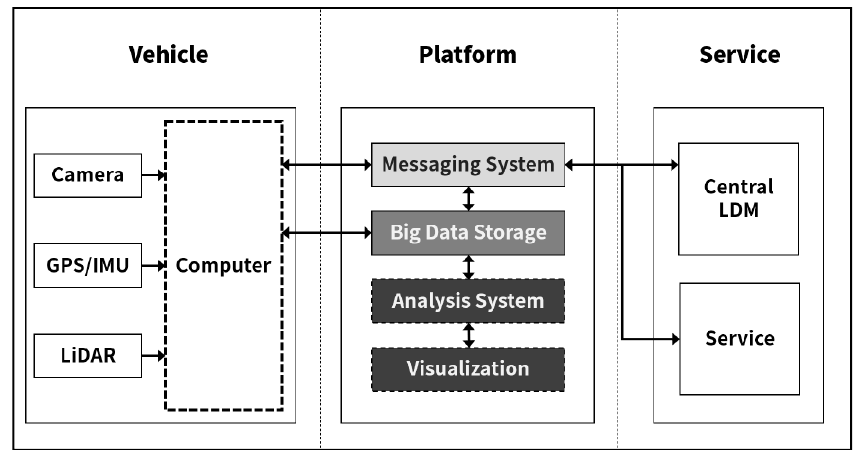
Figure 5. Overview of the proposed C-ITS environment.